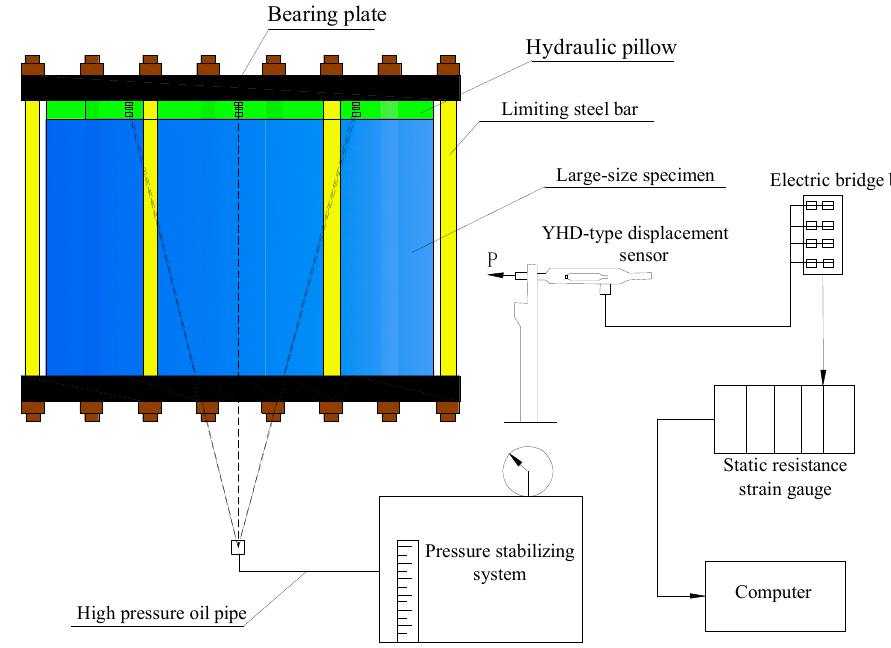
Figure 5. System component schematics.